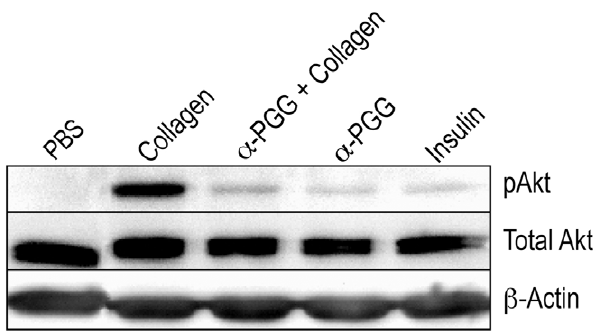
Figure 4. a -PGG inhibited thrombin induced rise in cytosolic calcium. Changes in cytosolic calcium were quantified in Fura2/AM loaded platelets. Platelets were incubated with a -PGG (3 or 10 m M) prior to stimulation with thrombin (0.1 U mL 2 1 ) and changes in calcium levels were recorded by fluorescence spectrometry as described in Experimental Procedures. The results are reported as means 6 SE (n=4). doi:10.1371/journal.pone.0026238.g004 PLoS ONE |